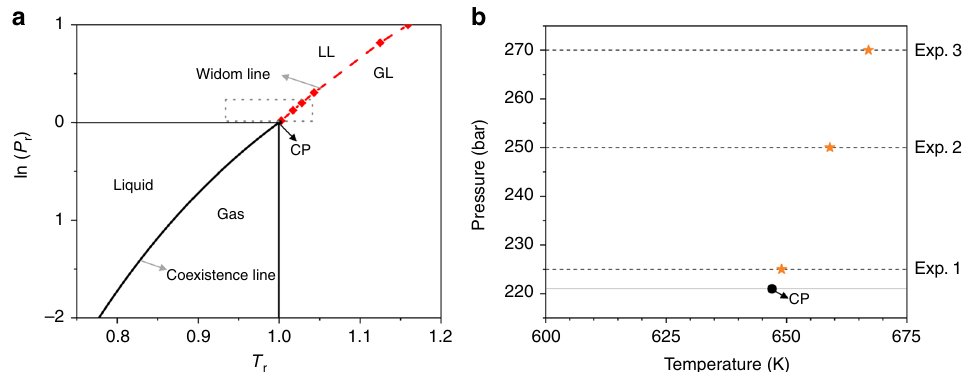
Fig. 1 Water phase diagram indicating the supercritical region analyzed in this article. a Water states in the plan of reduced pressure ( P r = P / P CP ) and reduced temperature ( T r = T / T CP ); coexistence line below critical point (CP) separates liquid and gas phases and Widom line above CP separates LL and GL supercritical water states; b the region of our experiments in pressure – temperature space; the orange symbols indicate the points of the pseudo -boiling line 25 for each isobar. Source data are provided as a Source Data fi